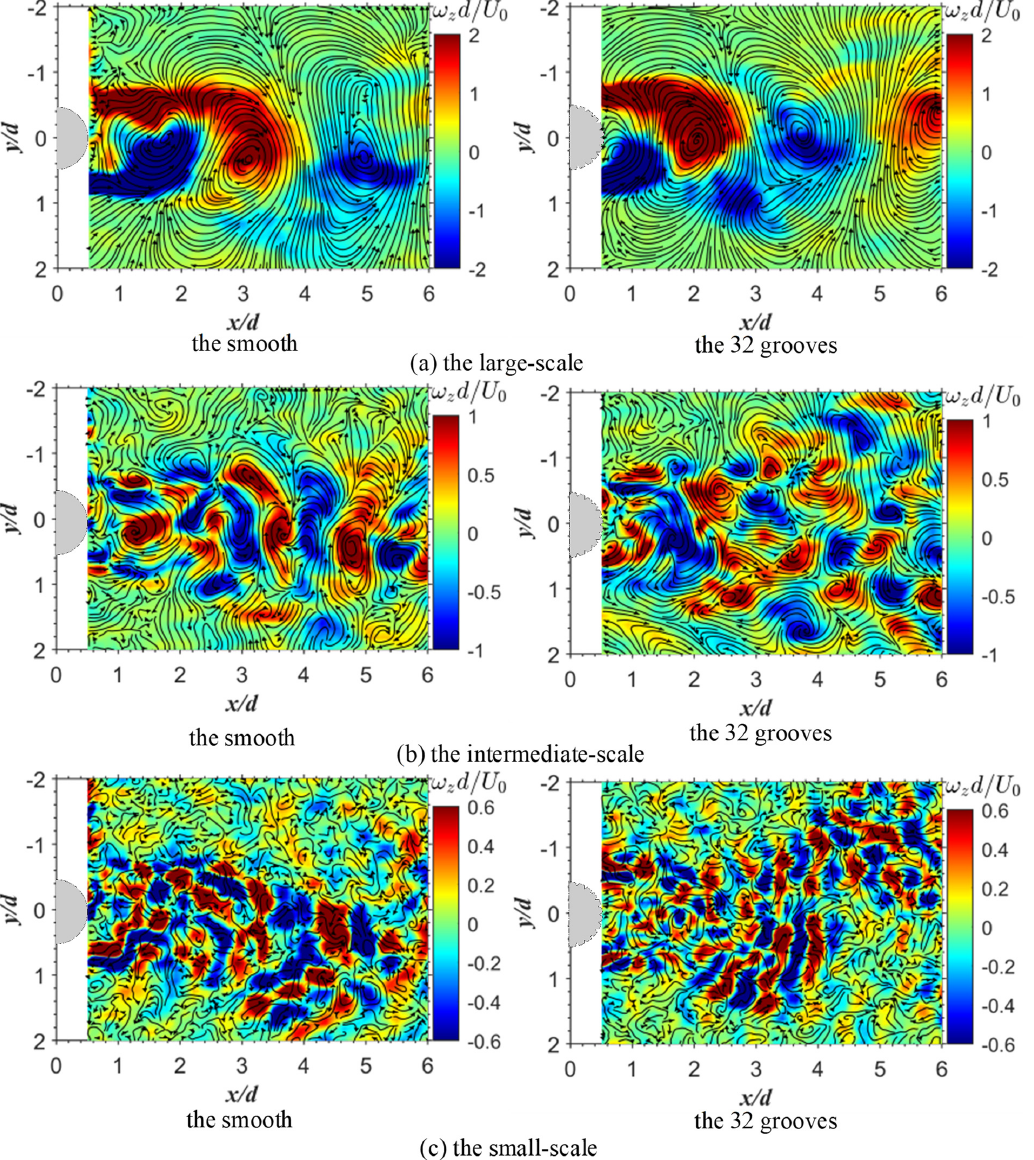
Figure 15. Multi-scale instantaneous streamlines and vorticity contours of the smooth and 32-groove cylinders in the ( x, y )-plane.